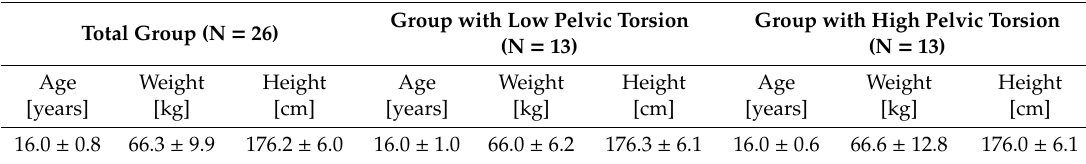
Table 1. Anthropometric data of total group and